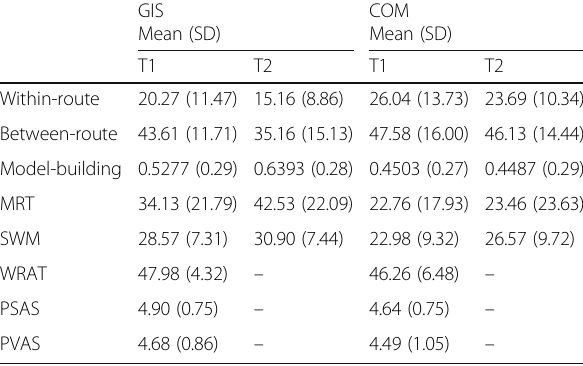
Table 1 Descriptive statistics by course for T1 and